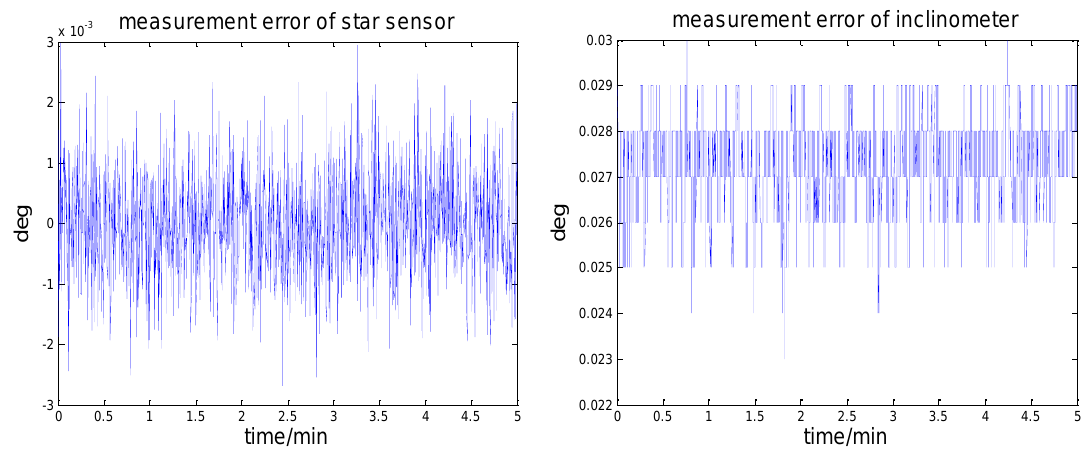
Figure 6. The measurement errors of the star sensor and the